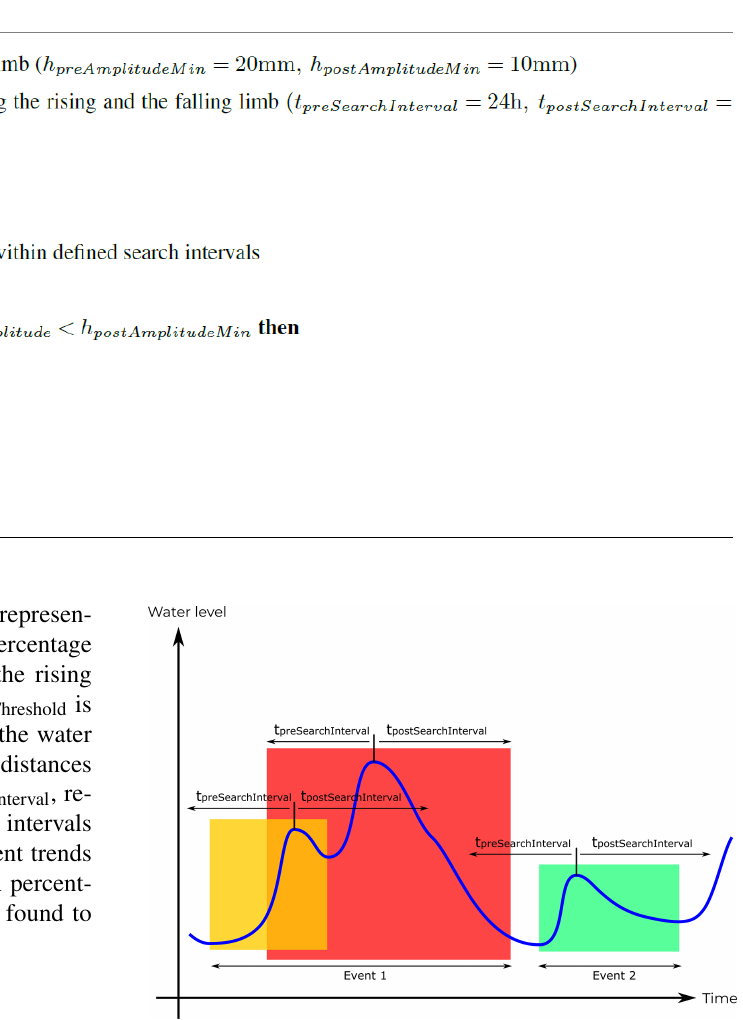
Figure 5. Merging conditions of consecutive events. Time series of water level showing three local maxima and the corresponding search windows for the minima. The coloured boxes mark the inde- pendently detected events as the interval between the two absolute minima around each peak within the respective search interval. The yellow and red events overlap and are merged into one. The green event is an independent second